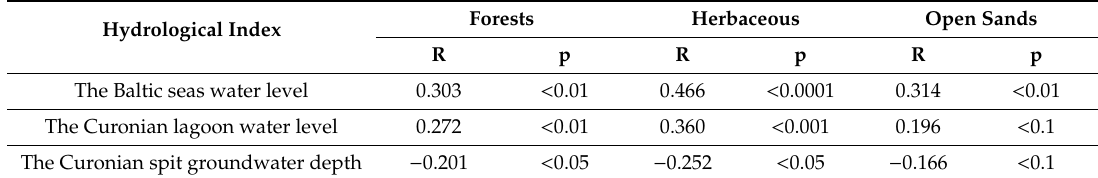
Table 4. Pearson correlation coe ffi cients (R) and statistical significance (p), comparing di ff erent ecosystems NDVI values and hydrological parameters average monthly values during the